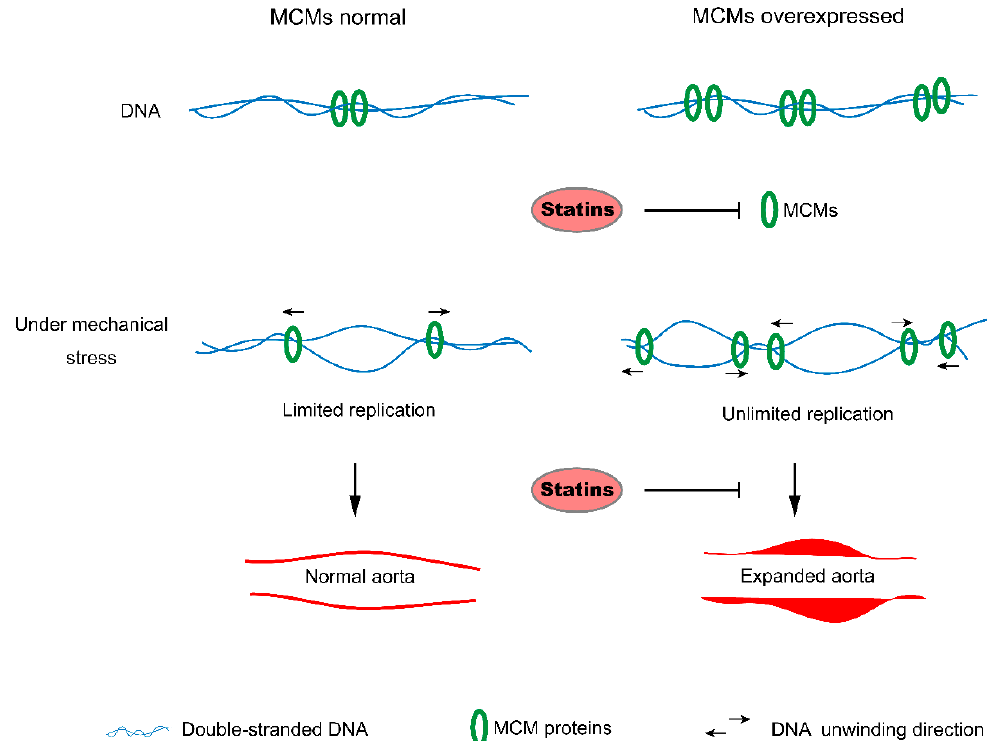
Figure 6. The model of MCM proteins’ role in the progression of aortic expansion. Under replication stress caused by mechanical stress such as hypertension, the limited MCM proteins in the normal aorta can slow down the proliferation of endothelial or smooth muscle cells through active DNA damage checkpoints. By contrast, upregulated MCM proteins may cause overproliferation of endothelial and smooth muscle cells and cause aortic expansion. Statins may prevent aortic expansion by targeting MCM proteins and inhibit the overreplication of cells.